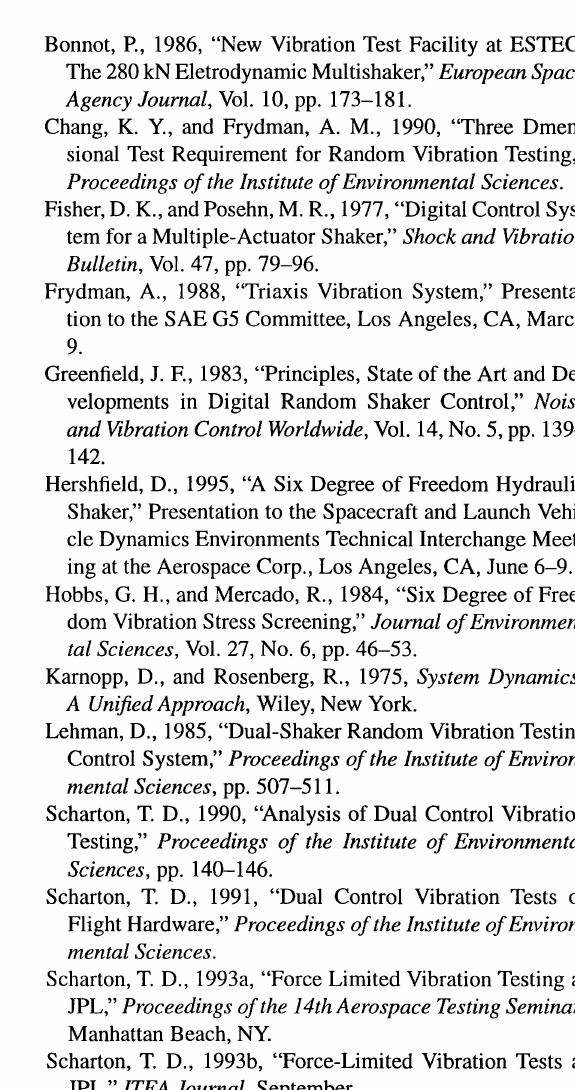
FIGURE 11 Ratio of spectra of test force to service force. M = 1.5, Ws = 1,1;0 = 0.1, I;s =